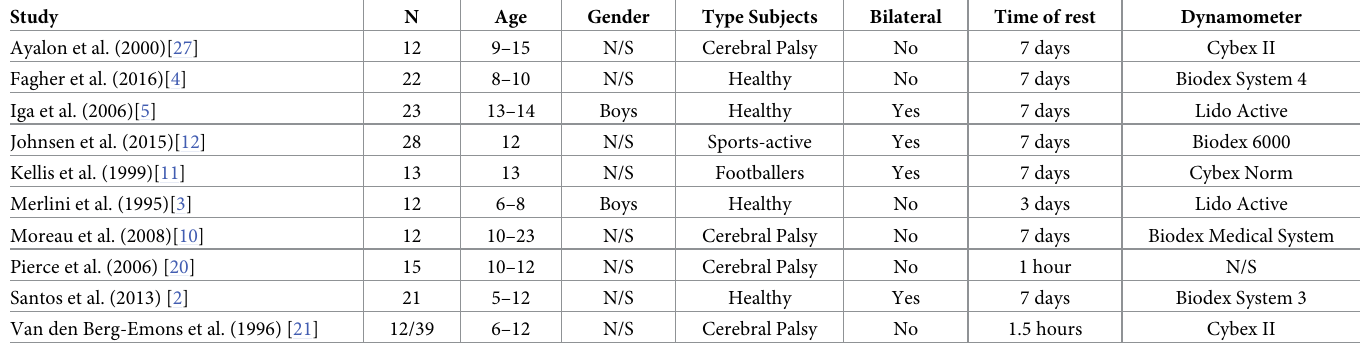
Table 3. Characteristics of the